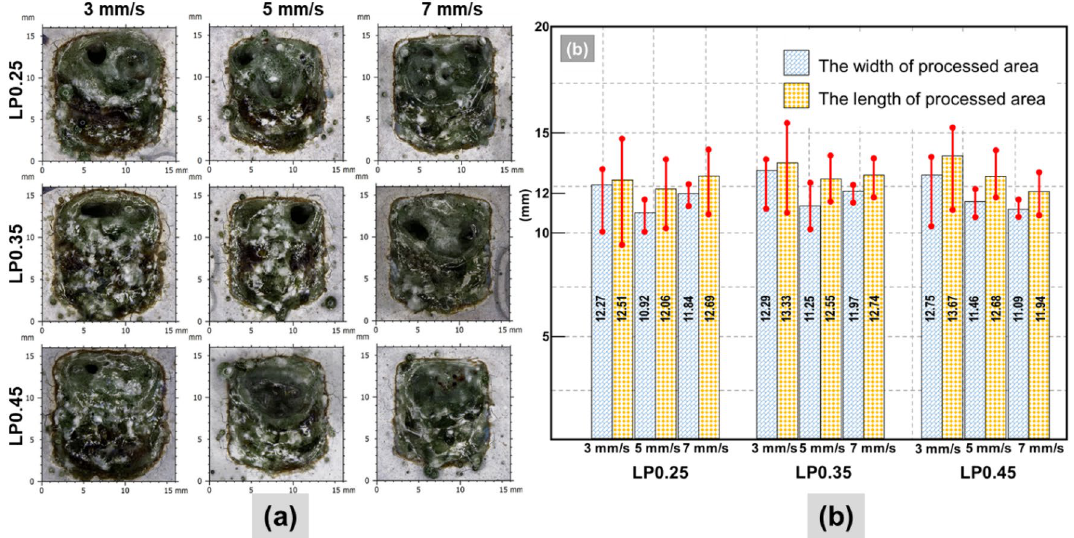
Figure 3. ( a ) Surface observation of LP series samples; ( b ) Dimension of LP series samples by using the confocal microscopy.